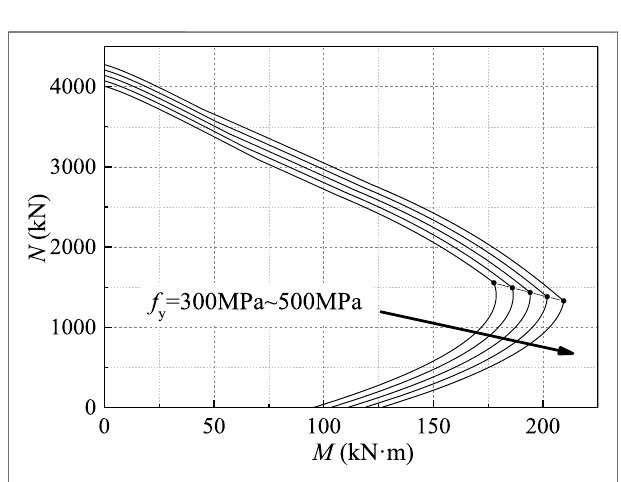
FIGURE 10 | N-M interaction curves with different tensile strengths of the steel bar.